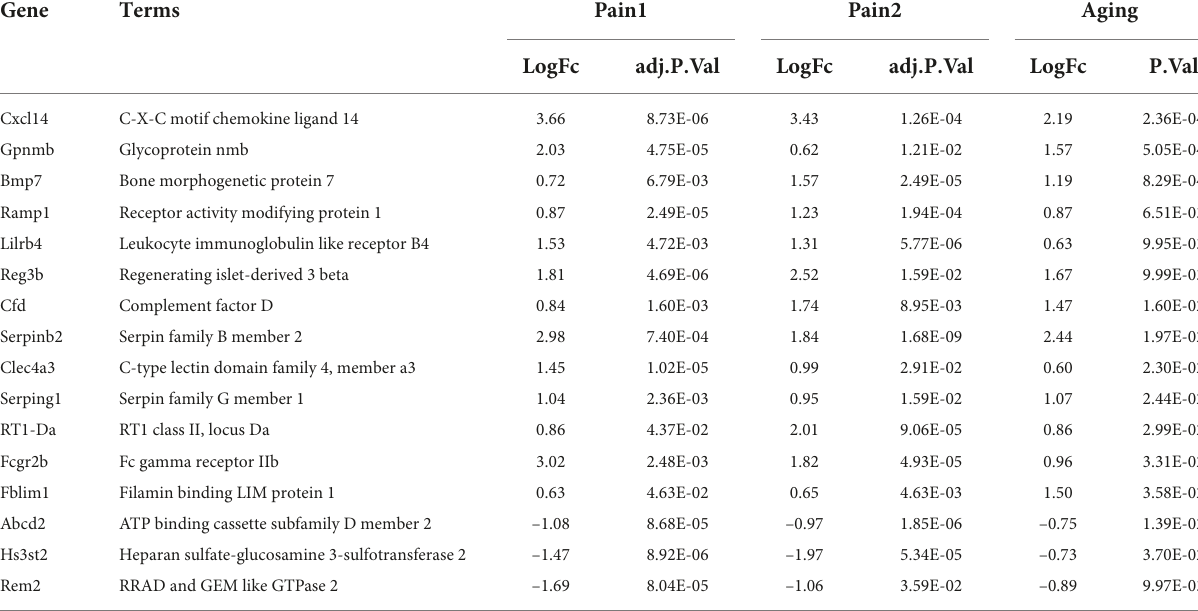
TABLE 1 16 co-DEGs between neuropathic pain and aging.